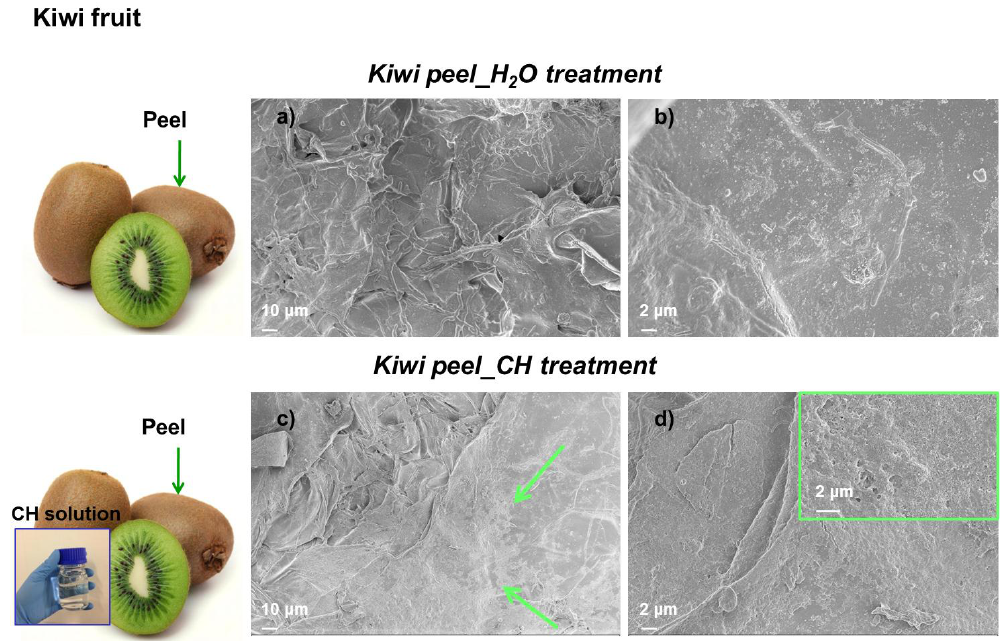
Figure 4. Evidence of CH coating on kiwifruit peel treated with ( a , b ) water as control and with ( c , d ) CH solution. Coatings 2017 , 7 , 196